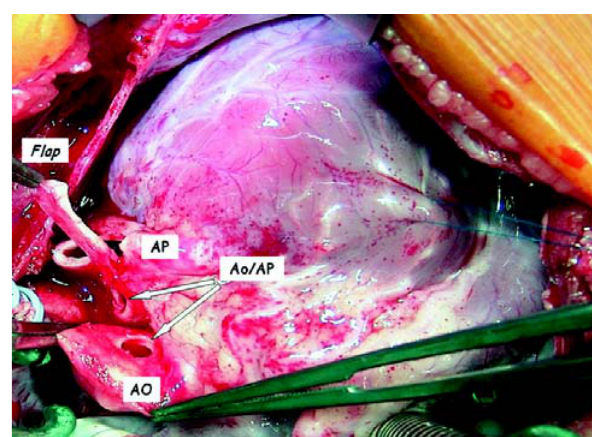
Fig. 2 – Aspecto intra-operatório com o flap de tecido da artéria pulmonar seccionado transversalmente para confecção do túnel.